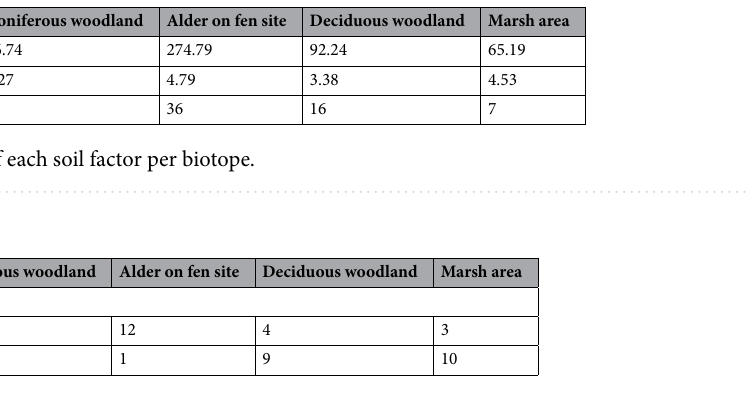
Table 6. Results of the median test on the number of collected Culicoides per biotope.